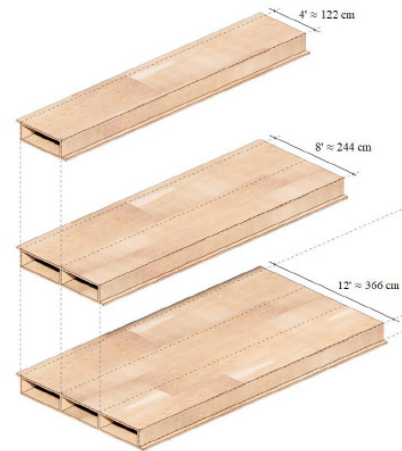
Figure 5. Wooden box elements [9].